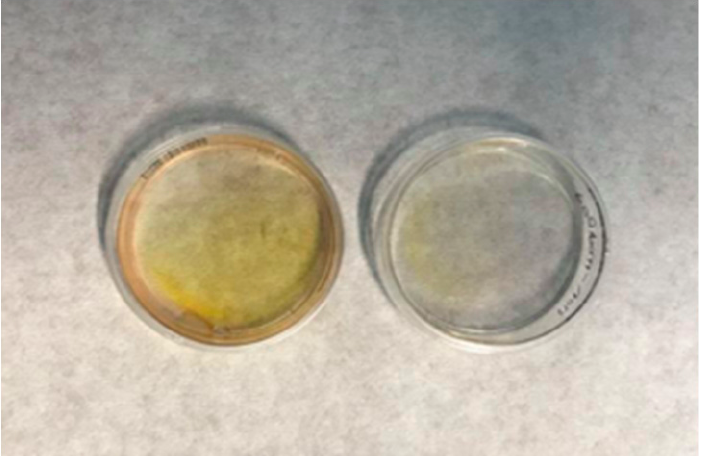
Figure 3. Illustration of the enzymatically modified (left) and non-modified (right) biopolymer membranes.